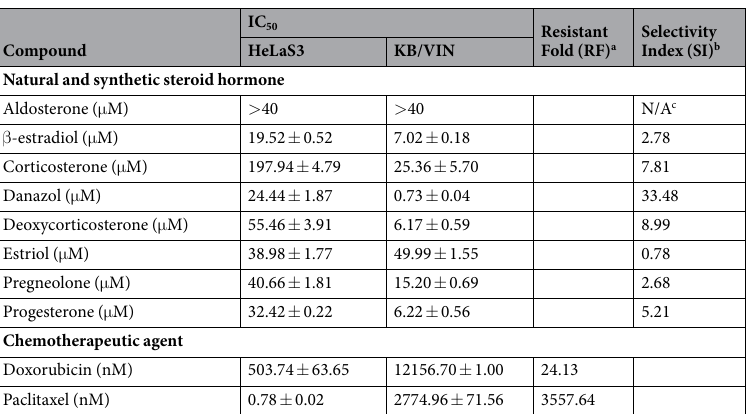
Table 2. Cytotoxicity of natural and synthetic steroid hormones on HeLaS3 (parental) and KB/VIN (MDR) cancer cell lines. a The resistant fold was calculated by dividing the individual IC 50 of KB/VIN by the IC 50 of HeLaS3. b The selectivity index was calculated by dividing the individual IC 50 of HeLaS3 by the IC 50 of KB/VIN. c Not